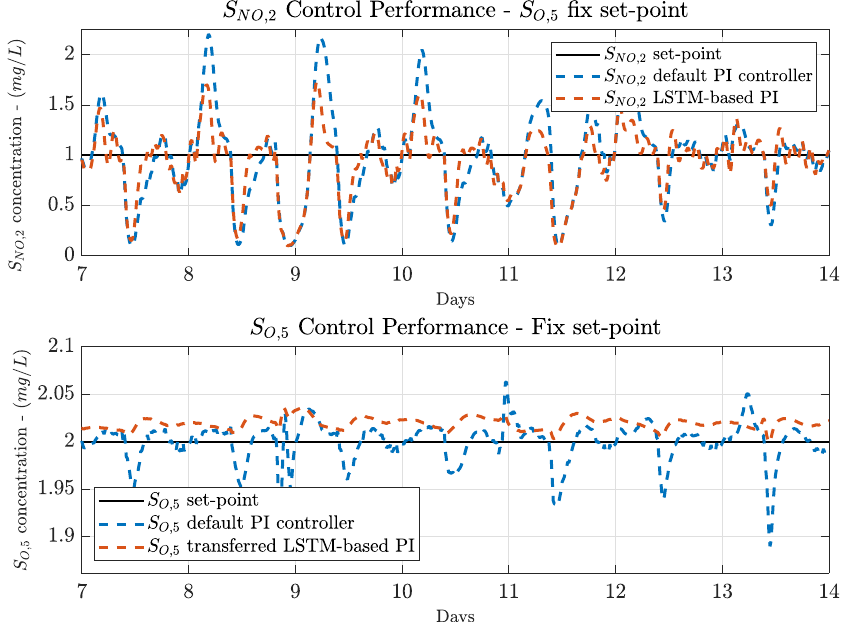
Figure 8. Control performance for the NO and DO control loops when the stormy weather is considered. The LSTM-based PI managing the DO control loop is derived from the NO control loop and transferred into the DO